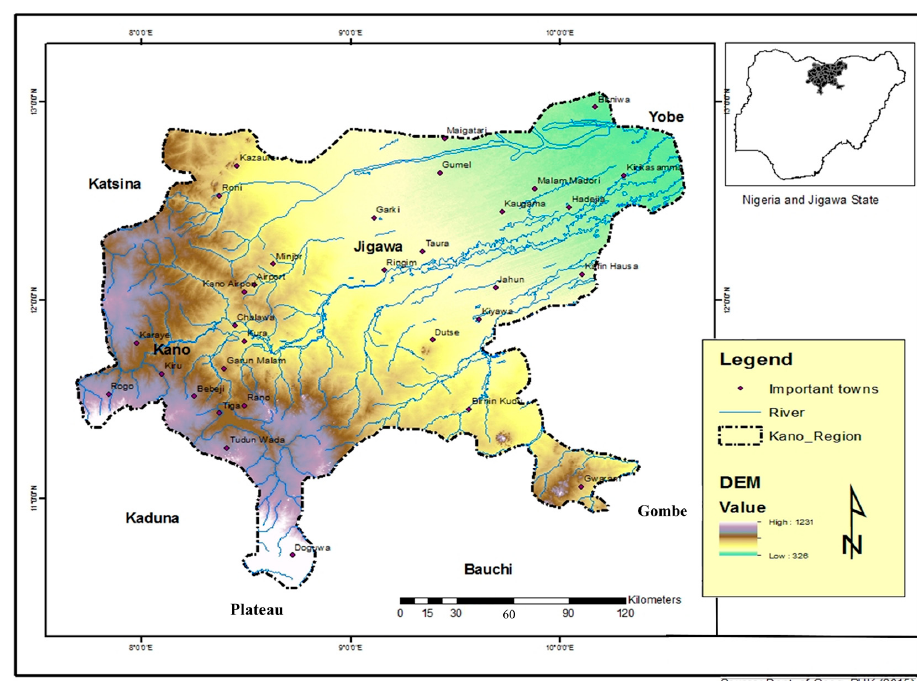
Figure 4. Elevation and Drainage of Kano Region.